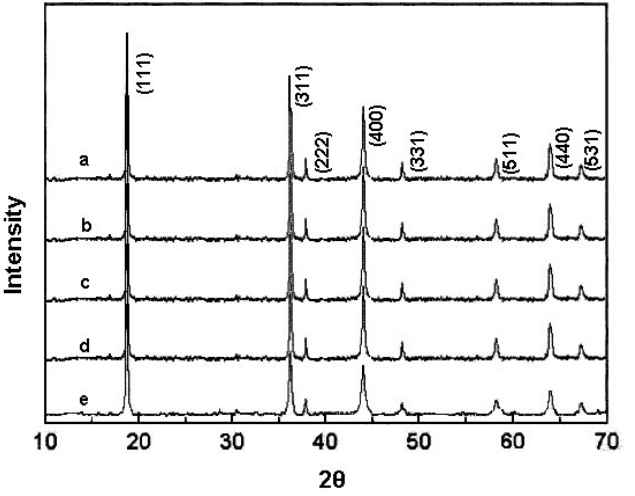
Figure 3. XRD patterns of (a) LiMn 2 O 4 (b) LiNd 0.1 Mn 1.9 O 4 (c) LiNd 0.2 Mn 1.8 O 4